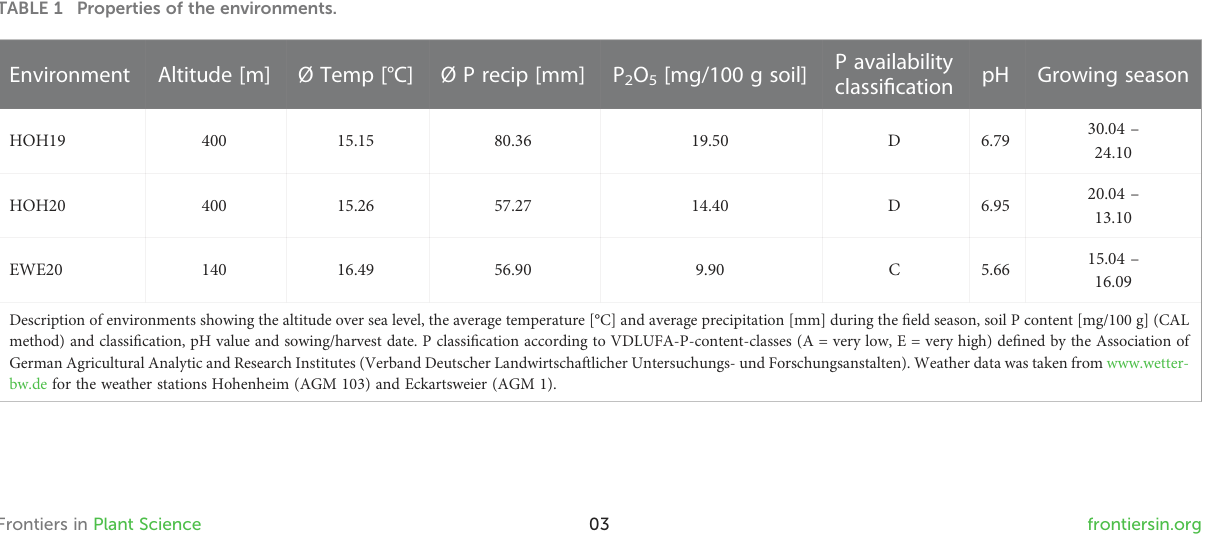
TABLE 1 Properties of the